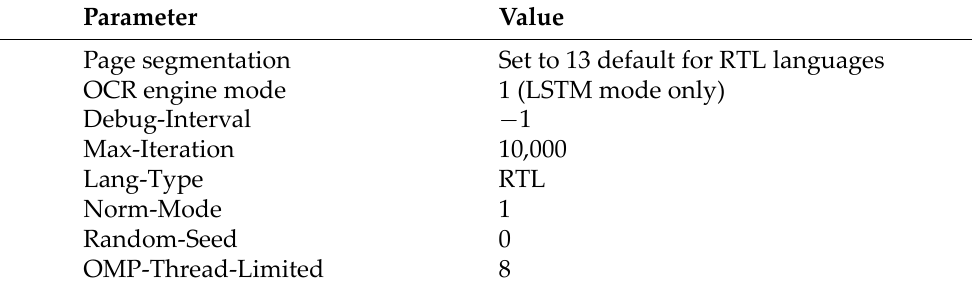
Table 10. Training